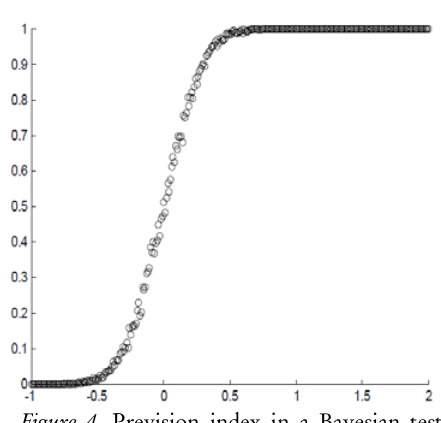
Figure 3 - Prevision index in a Bayesian test case where